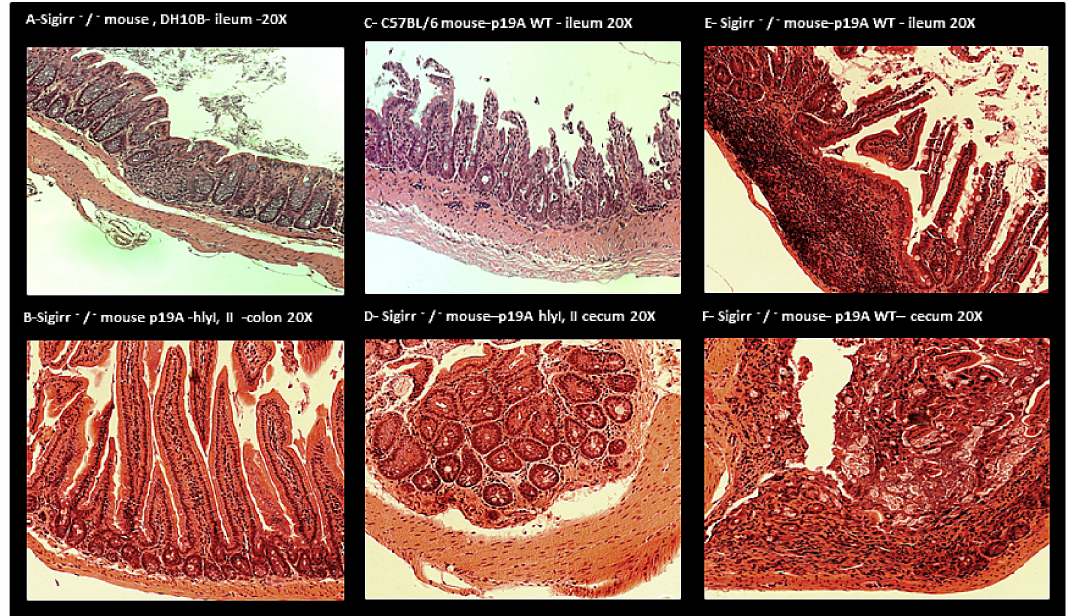
Figure 6. The histology / hematoxylin and eosin (HE) staining of the intestinal tissue of colonized mice. ( A ) DH10B infected Sigirr − / − mouse, showing no signs of tissue damage in the ileum. ( B ) p19A ∆ hlyI, II infected Sigirr − / − mouse showing no signs of tissue damage in the colon. ( C ) p19A WT infected C57BL / 6 mouse showing inflammation / increased leucocytes and thickness of smooth muscle and ulcer formation in the ileum. ( D ) p19A ∆ hlyI, II infected Sigirr − / − mouse showing no signs of tissue damage or inflammation in the cecum. ( E ) p19A WT infected Sigirr − / − mouse showing inflammation / increased leukocytes in the Peyer patches and tissue damage. ( F ) p19A WT infected Sigirr − / − mouse showing inflammation / increased leucocytes and initiation to ulcerative formation in the